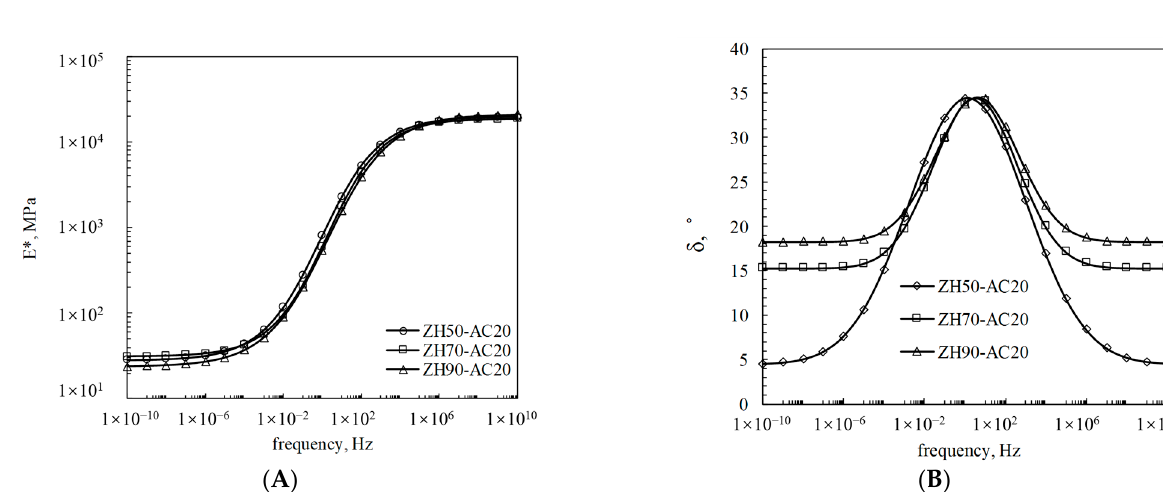
Figure 2. Master curves of three kinds of asphalt mixtures. ( A ) Dynamic modulus master curve, ( B ) Phase angle master curve.